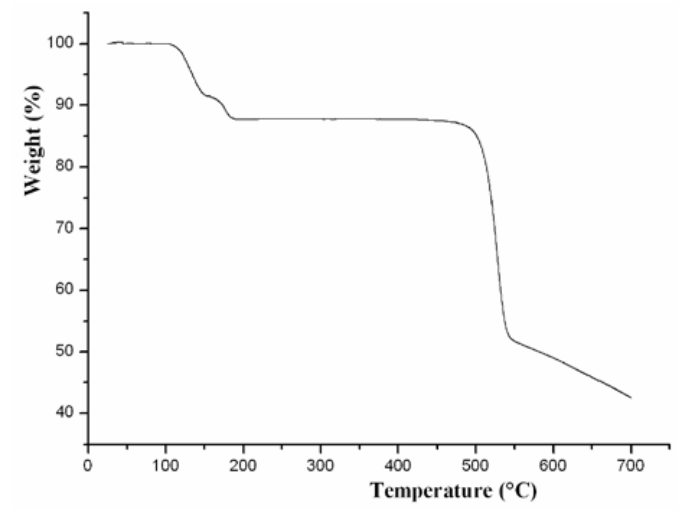
Figure 6. Thermal analysis curve of the complex 1 .